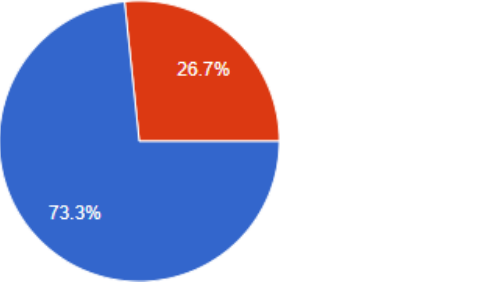
Figure A4. A survey report showing percentages of responders faced fraudulent activities .